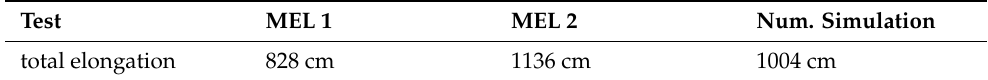
Table 5. Total sumofbrakes elongationcomparisonbetween MEL 1, MEL2, and thenumericalsimulation.